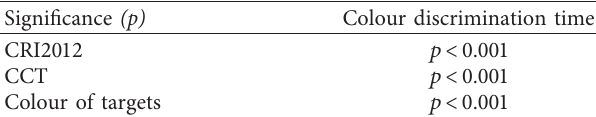
Figure 19: The reaction time of all observers under different CRI2012s and CCTs. Table 3: Correlation analysis of all experimental